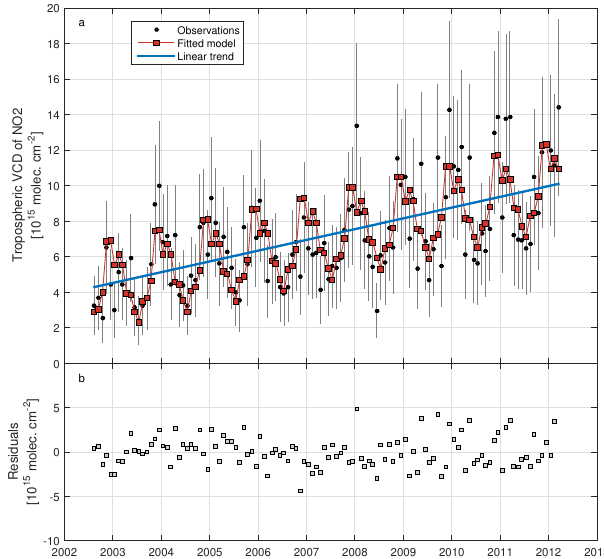
Figure 2. Example of a SCIAMACHY-derived time series of monthly mean tropospheric NO 2 column (given in units of × 10 15 moleculescm − 2 ) including estimated uncertainty for the city of Baghdad, Iraq and the fitted statistical model including linear trend (top) and the corresponding residuals of the fitted model (bot- tom) (given in units of × 10 15 moleculescm − 2